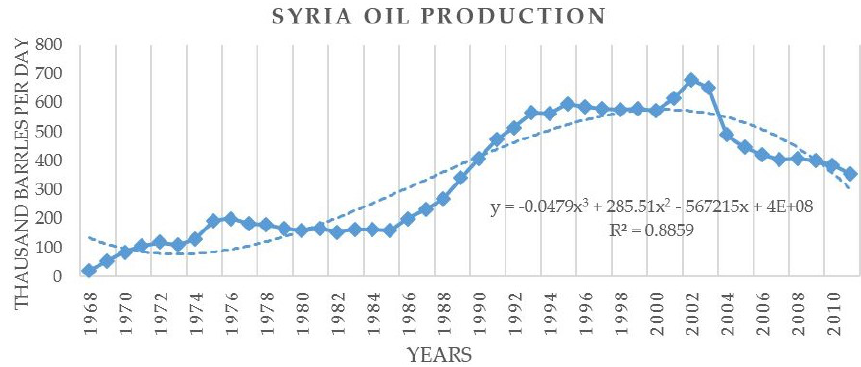
Figure 3. Syria’s oil production, based on data of the BP Statistical Review of World Energy [3].